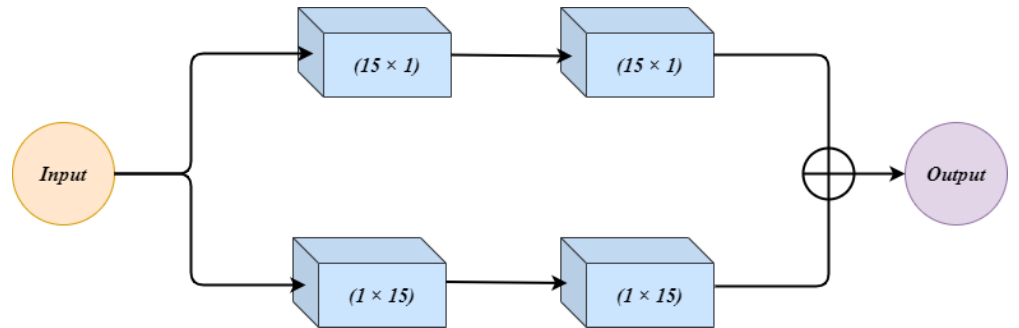
Figure 4. The architecture for the Wide Context (WC)